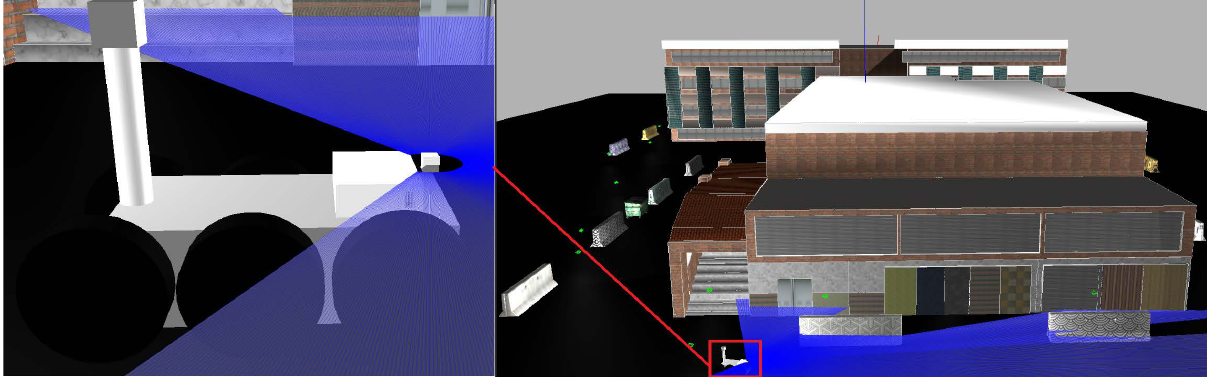
Figure 3. The ROS Gazebo simulation of the refectory buildings ( right ) and the simulated UGV/robot ( left ) moving in the